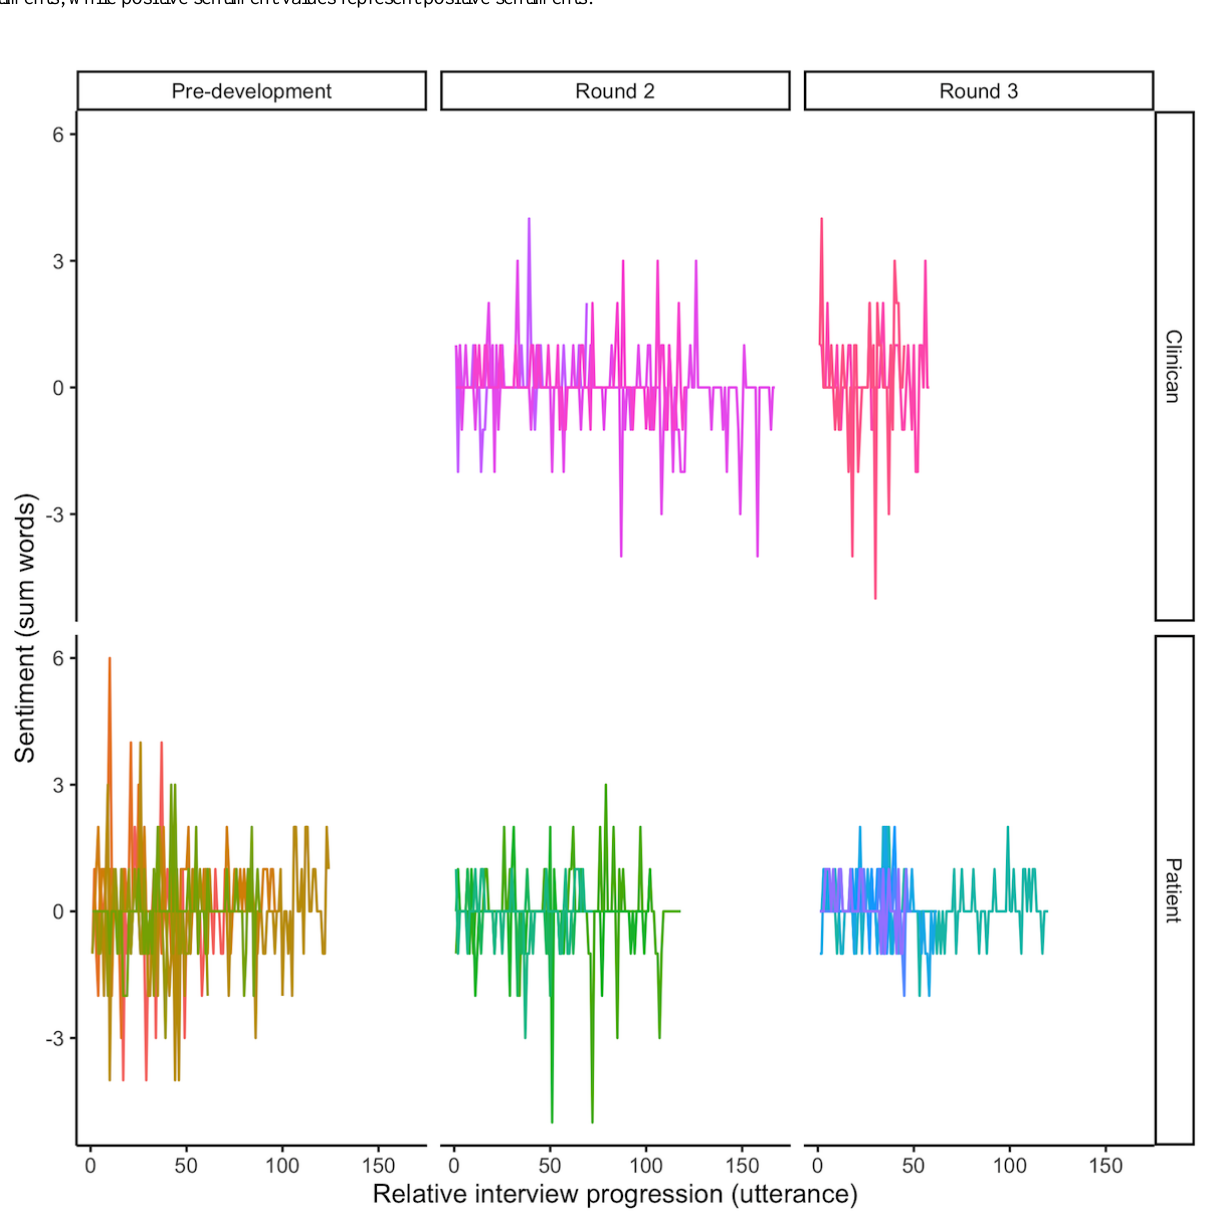
Figure 5. Sentiment over the course of the interview for clinicians and patients in each round of interviews. Negative sentiment values represent negative sentiments, while positive sentiment values represent positive sentiments.